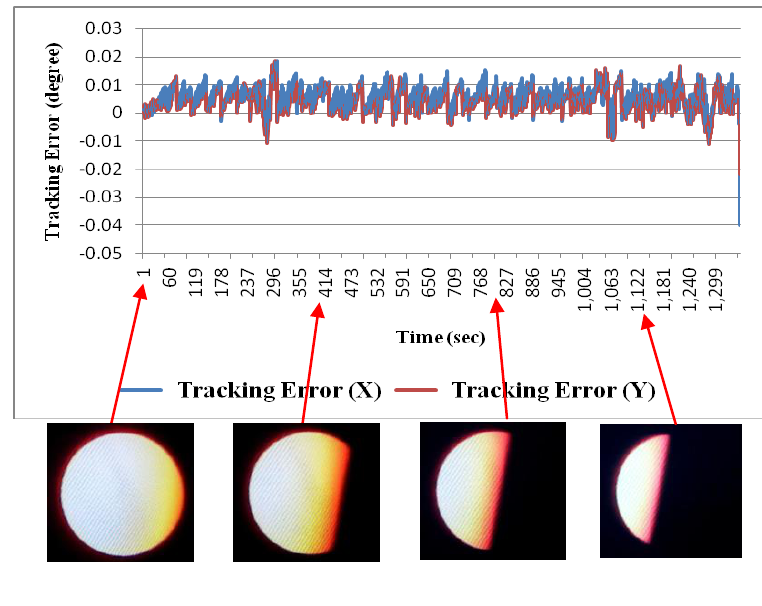
Figure 13. Tracking errors for Sun image